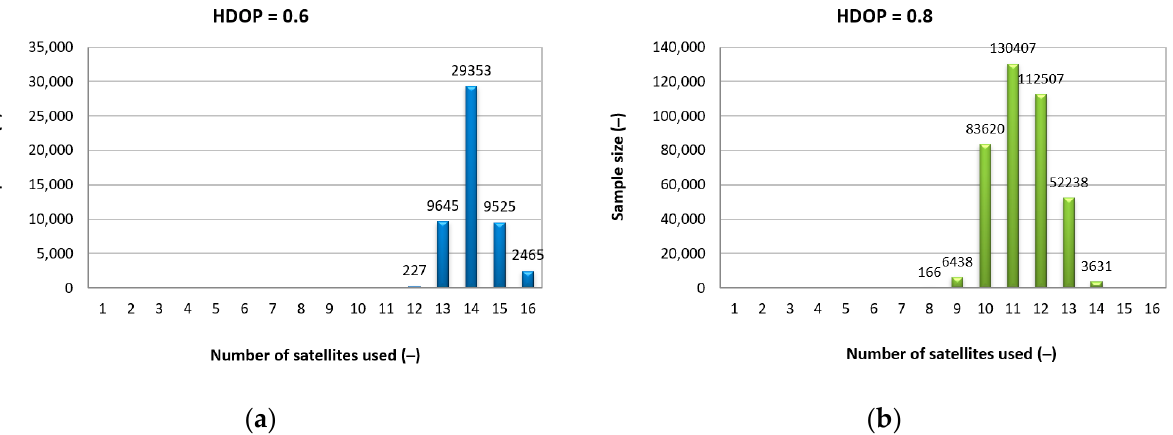
Figure 4. The number of GPS satellites used to determine the position at HDOP = 0.6 ( a ) and HDOP = 0.8 ( b ) [8].